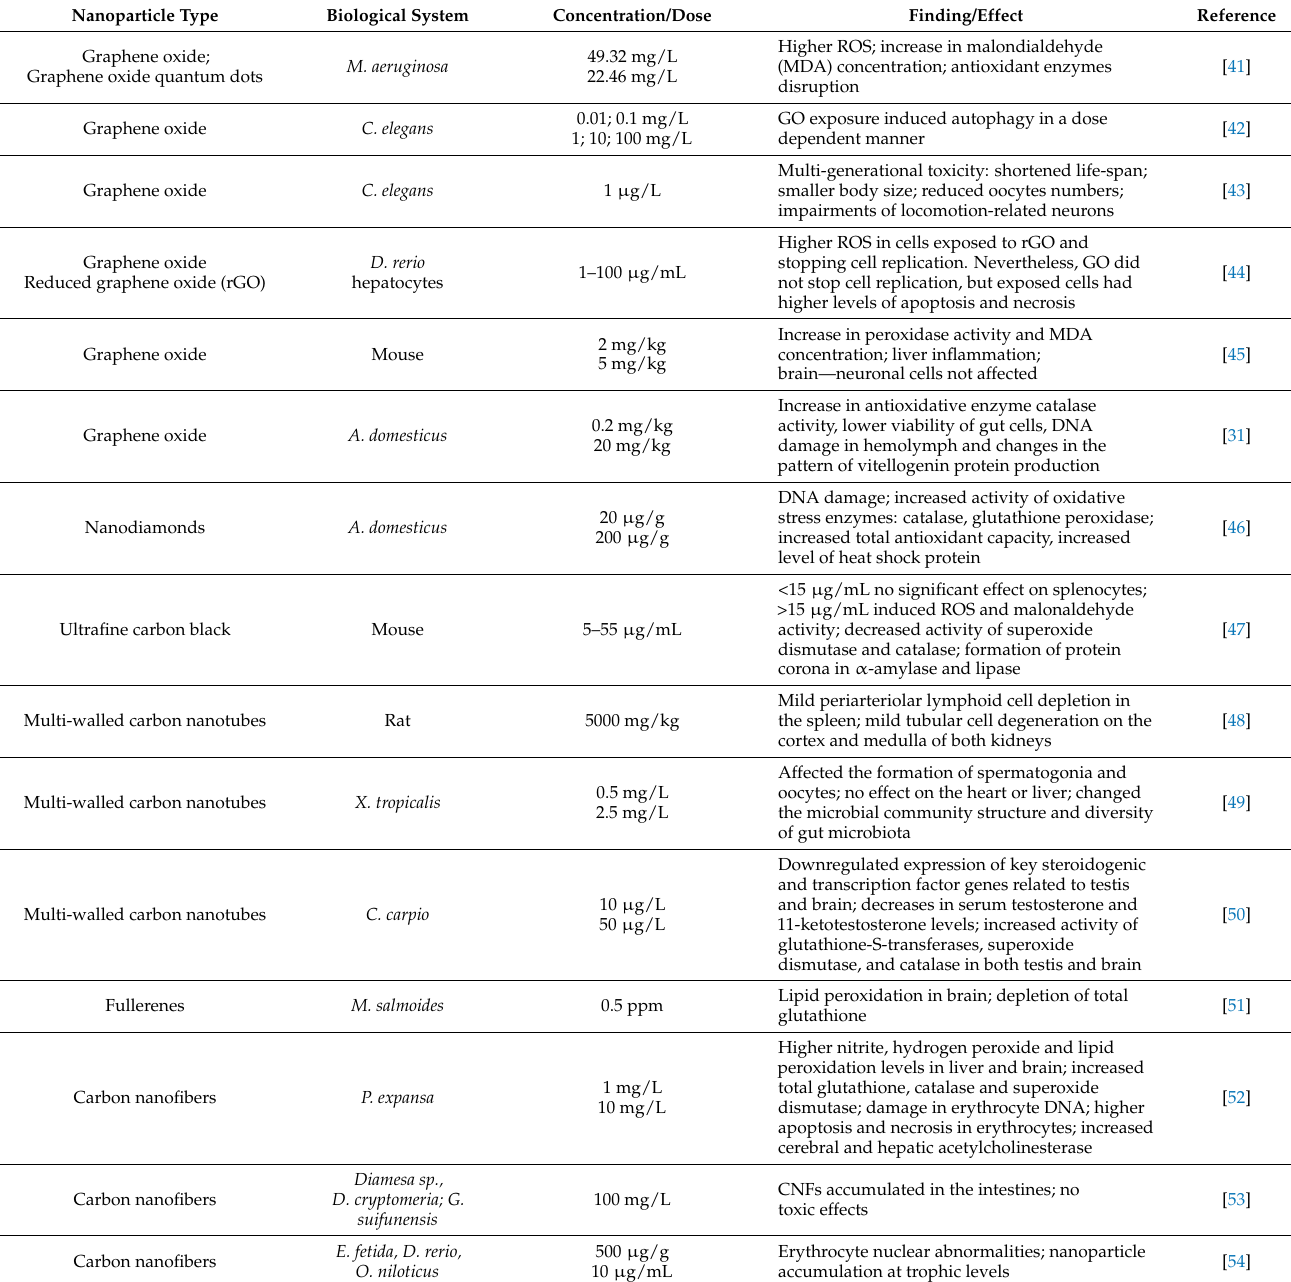
Table 3. Cellular and tissue toxicity of different carbon nanoparticle